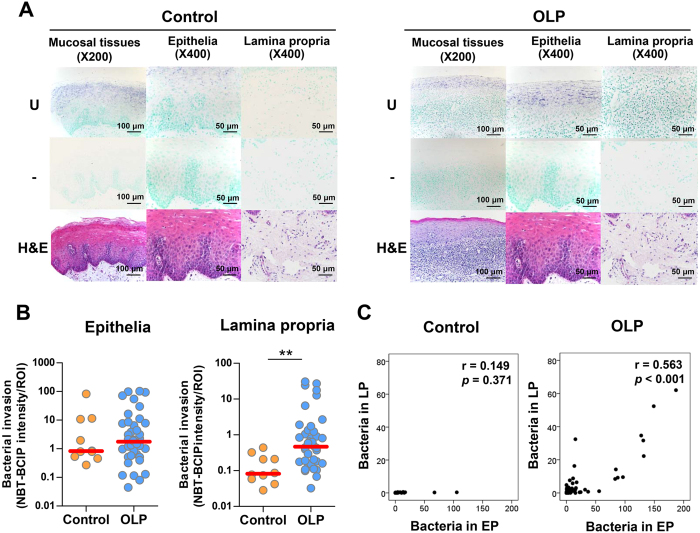
Increased bacterial invasion into the lamina propria in OLP tissues.(A) Representative in situ detection of bacteria in the control (n = 10) and OLP tissues (n = 36). U, a universal probe targeting bacterial 16S rRNA; -, a negative control probe mixed with 10-fold excess of unlabeled probe; H&E, hematoxylin and eosin stain. (B) The mean intensity of bacterial signals per region of interest (ROI) in the epithelia and lamina propria was analyzed using ImageJ software. The red bar indicates the median of each group (**P < 0.01 by Mann-Whitney U test). (C) Correlation plots between the levels of bacteria in the epithelia and those in the lamina propria in each group (r and P by Spearman’s rank correlation test).